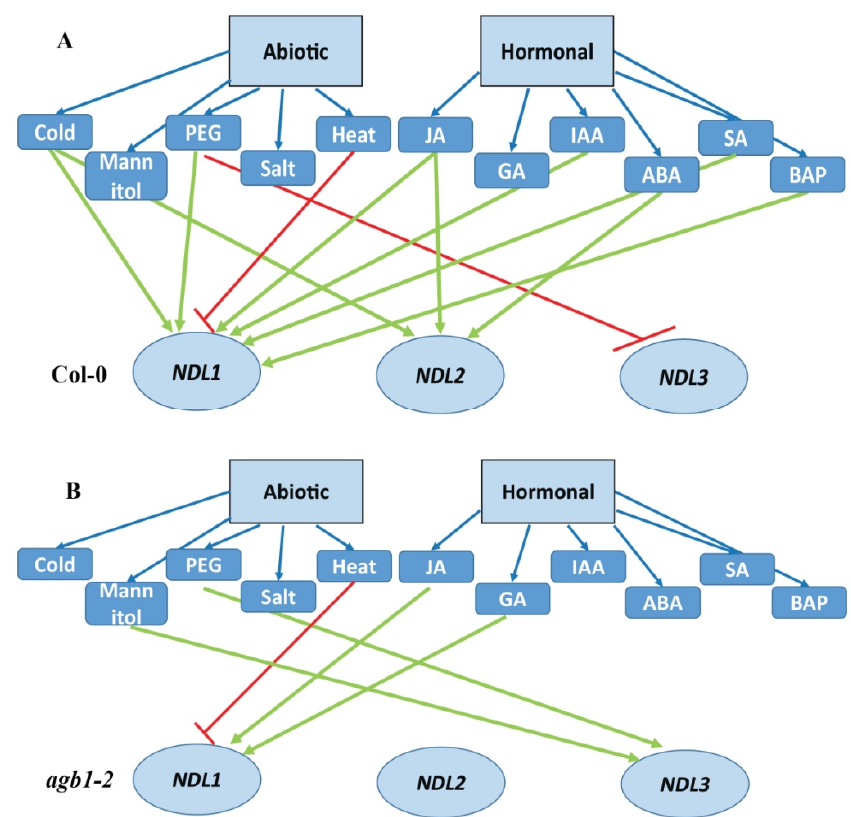
Figure 10. AtNDLs responses to various abiotic and hormonal treatments in presence and absence of AGB1: ( A ) Diagrammatic representation of AtNDLs in wild type background in response to various abiotic and hormonal treatments. ( B ) AtNDLs responses to various abiotic and hormonal treatments in agb1-2 mutant background. The green lines indicates that the gene was up regulated while the red lines indicates the downregulation of gene after the respective treatments.